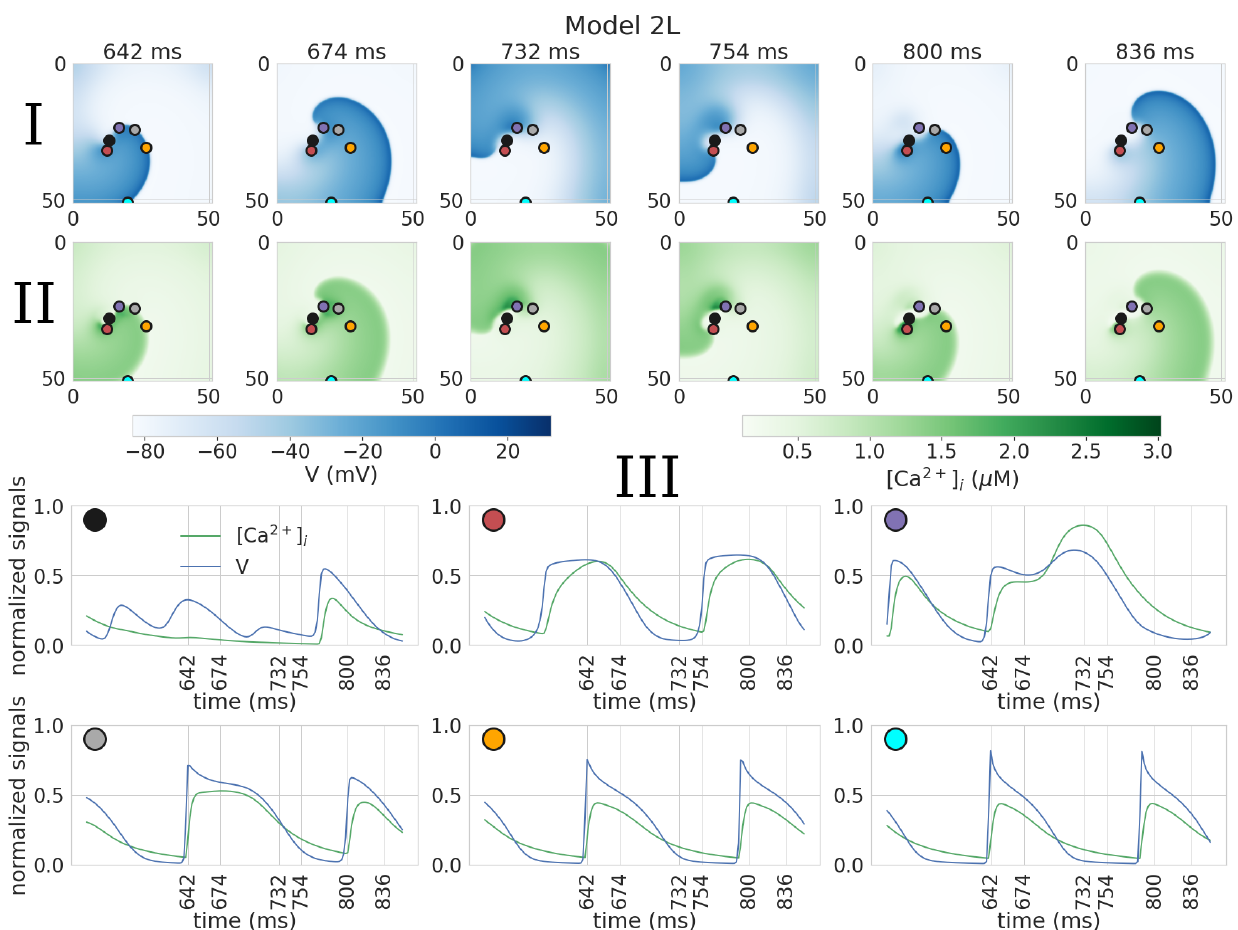
Figure 6. Formation of abnormal action potentials close to the tip of the spiral wave in 2D tissue with cellular model 2L. Action potential (I); calcium transient (II) maps; III: normalized signals of the action potential and calcium transient, recorded at the points indicated on the graphs above by corresponding